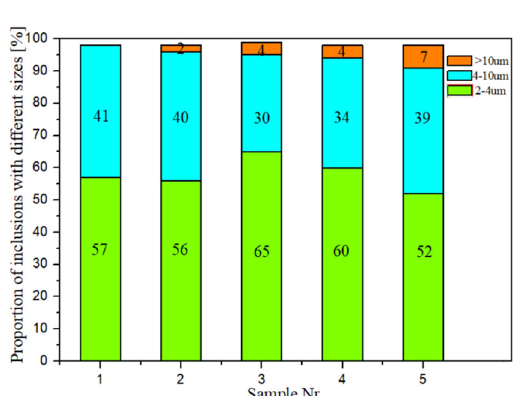
Figure 5. The relationship between Al in ULC automotive steel.